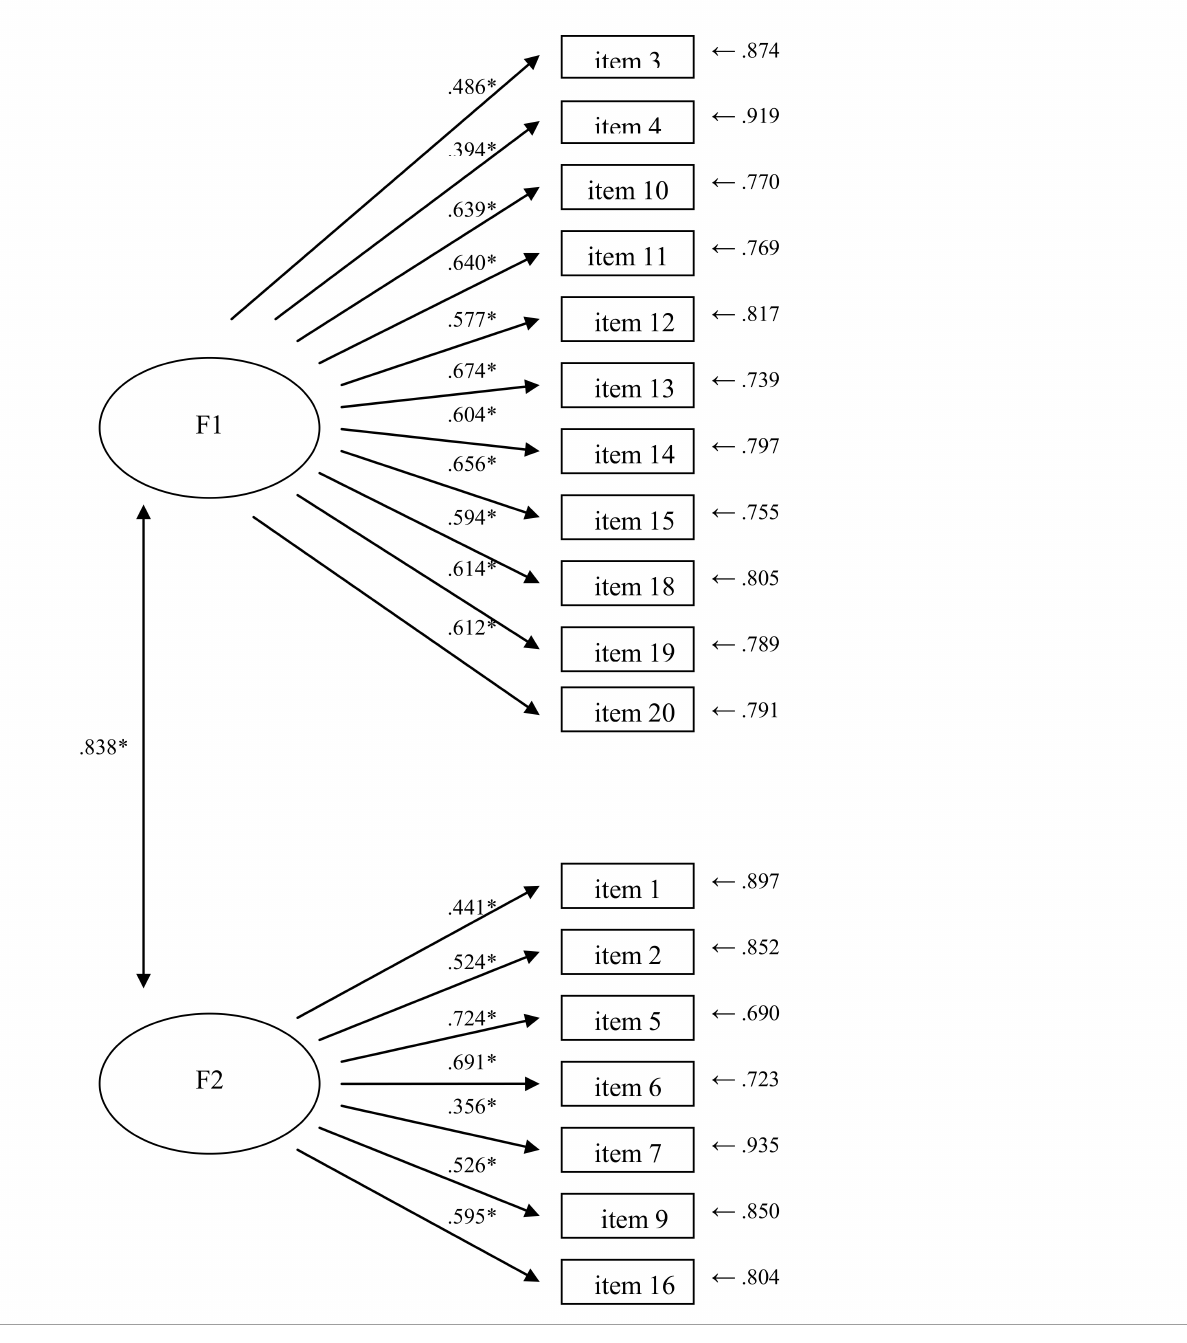
Figure 1. IAT empirical model (standardized solution). Note: F1 = Emotional and Cognitive Preoccupation with the Internet; F2 = Loss of Control and Interference with Daily Life. *